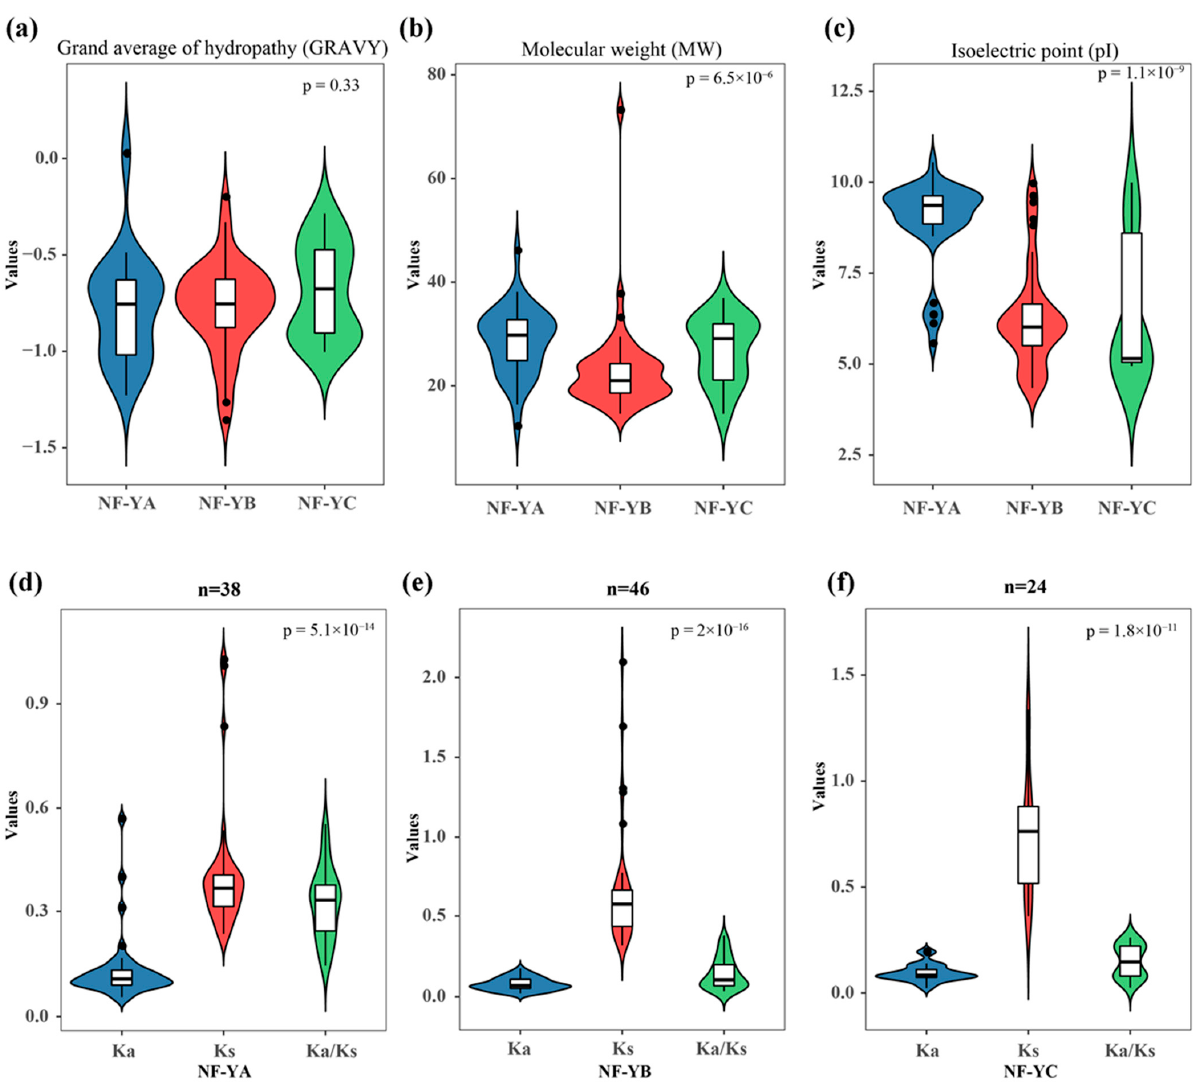
Figure 3. Harp diagrams of the molecular characteristics of NF-Y proteins and the synonymous (Ks), nonsynonymous (Ka) and Ka/Ks ratio of each NF-Y subfamily in rapeseed. ( a ) Grand average of hydropathy (GRAVY); ( b ) Molecular weight (MW); ( c ) Theoretical isoelectric point (pI); The GRAVY value is defined as the sum of the hydropathy values of the amino acids divided by the protein length. ( d – f ) Ka, Ks, Ka/Ks ratio of the NF-YA : ( d ) NF-YB ; ( e ) NF-YC ; ( f ) Subfamilies.